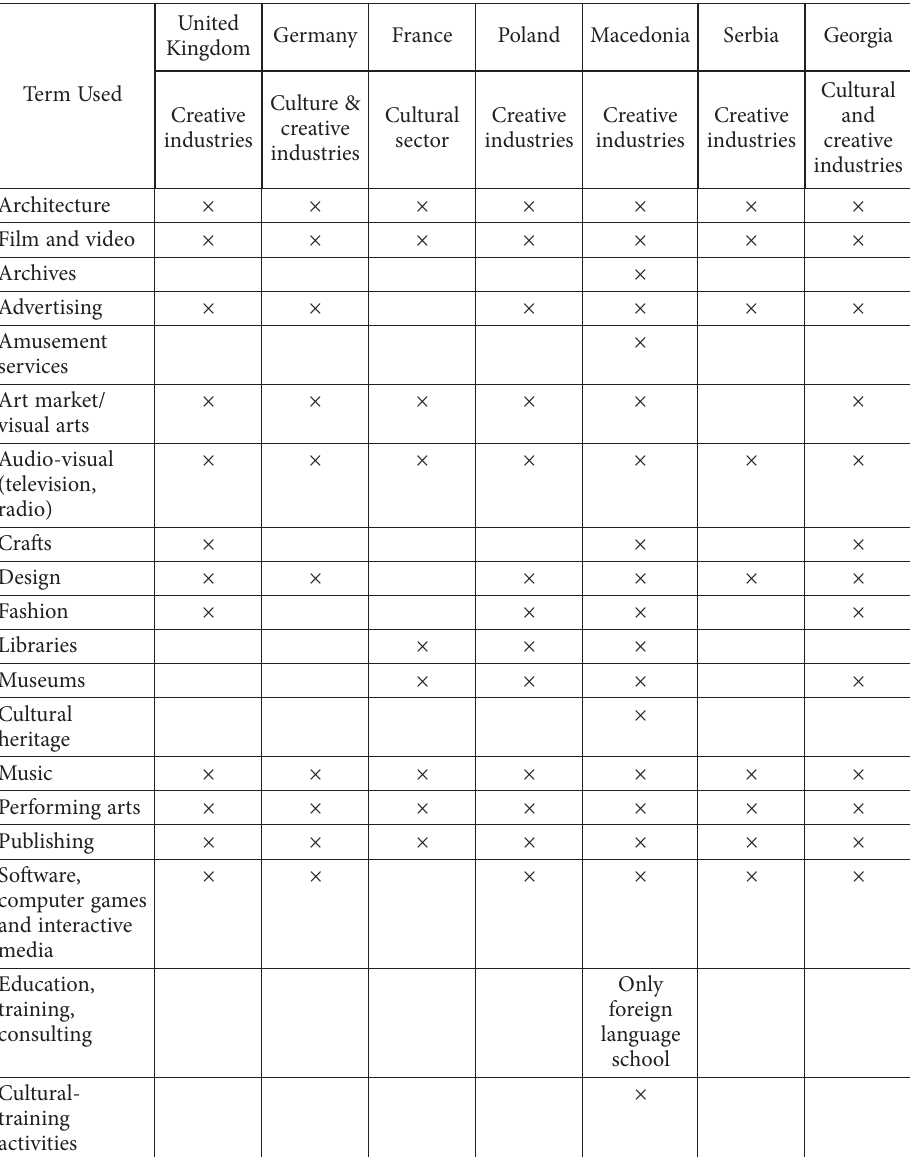
Table 3. Comparison of countries: definitions of the creative/cultural industries (source: created by authors)